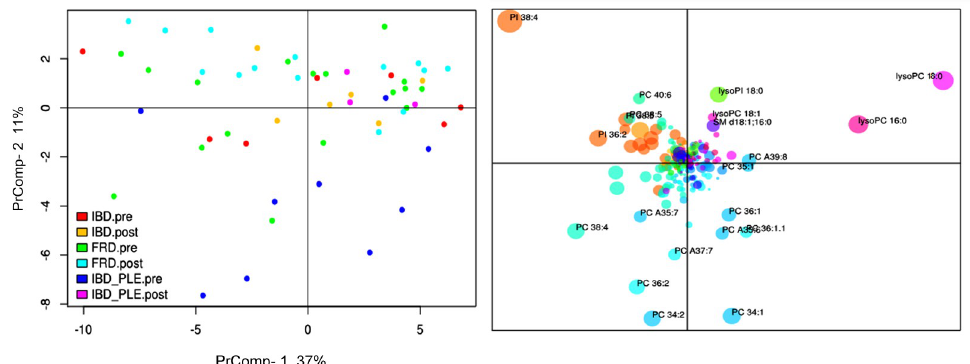
Fig 2. Principal component analysis (PCA) of the phospholipid profile in whole blood samples. In the score plot (left panel, for annotations see Fig 1) samples are color-coded by disease category and treatment status. The post-treatment samples are clustered in the upper right quadrant. In the corresponding loadings plot (right panel) lysolipid species are the predominant phospholipids in the upper right quadrant, indicating that the level of lysolipids increases after treatment. PrComp, principal component; PC, phosphatidylcholine; SM, sphingomyelin; PI, phosphatidylinositol.